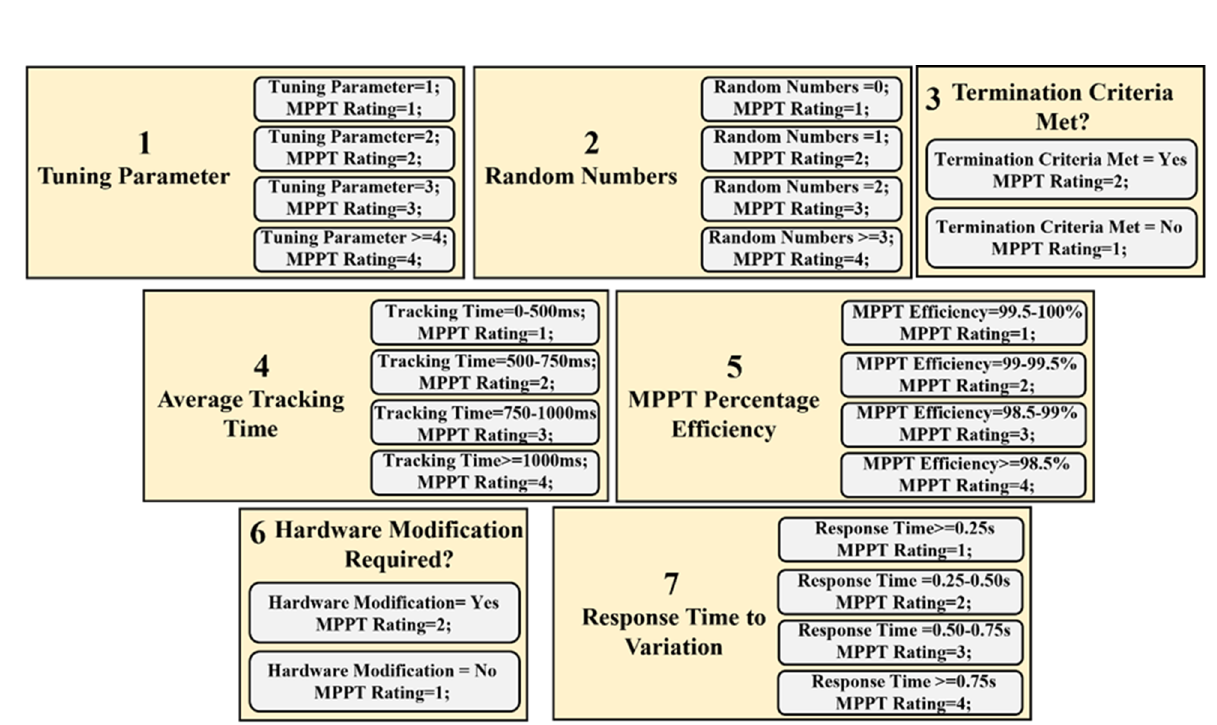
Figure 12. MPPT rating criteria in fi gure form.